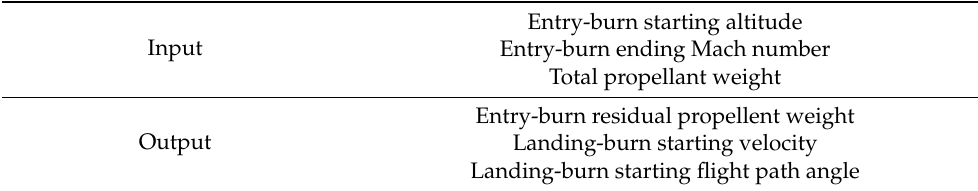
Table 4. Input and output parameters of the entry-burn and free-flight modules.